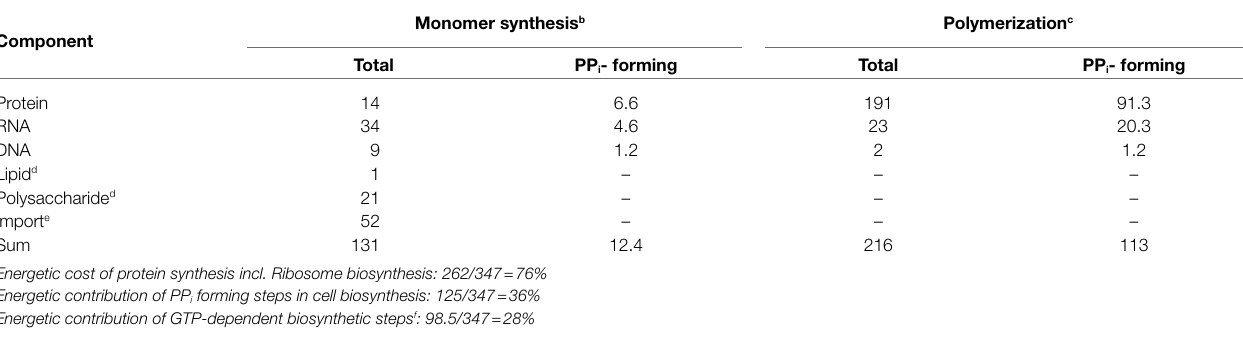
TABLE 1 | ATP expense per gram of cells during biosynthetic processes a [mol·10 4 ].